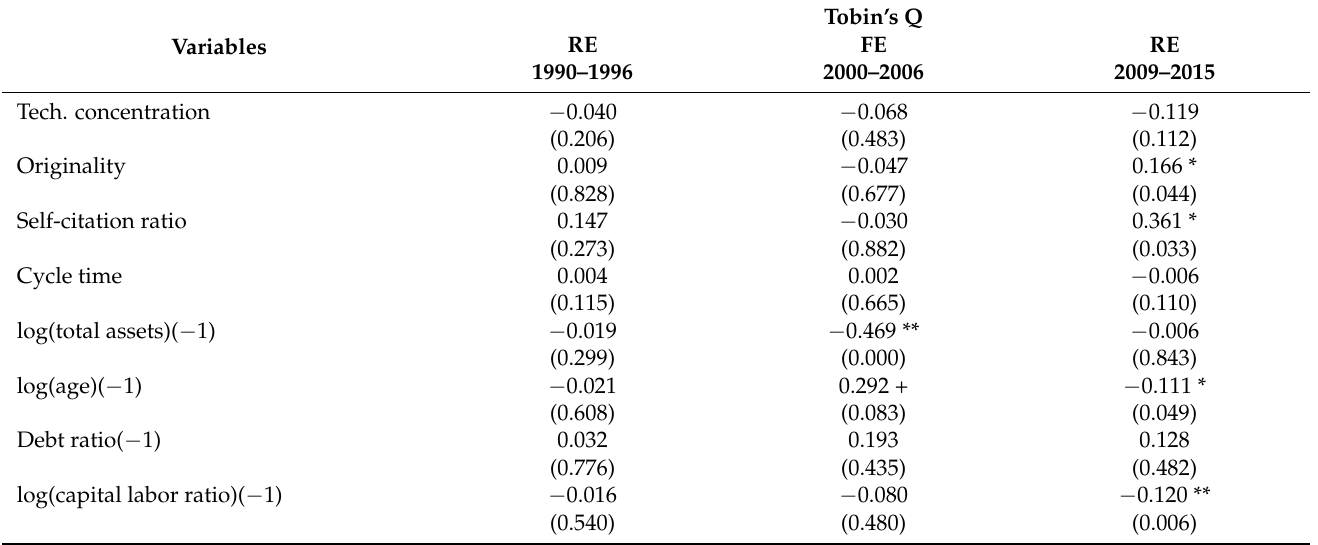
Table 10. Regression results of firm value on innovation